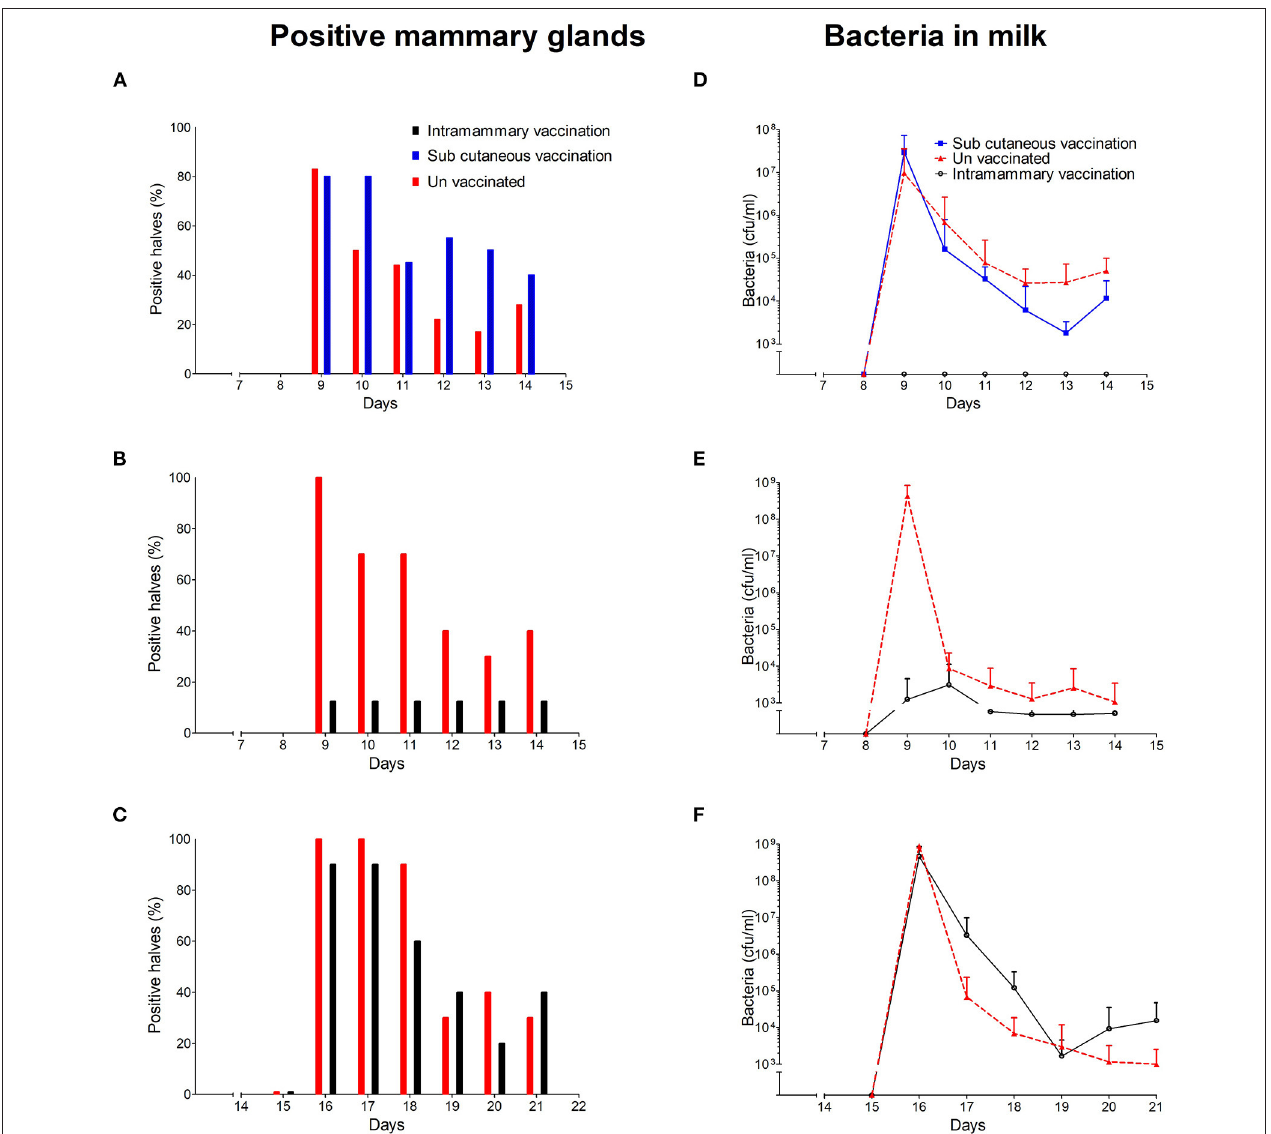
FIGURE 2 | The percentage of M. haemolytica positive mammary glands in study 1 (A) , study 2 (B) , and study 3 (C) . The concentration of M. haemolytica in milk from study 1 (D) , study 2 (E) , and study 3 (F) . Average bacterial concentrations with standard deviations are